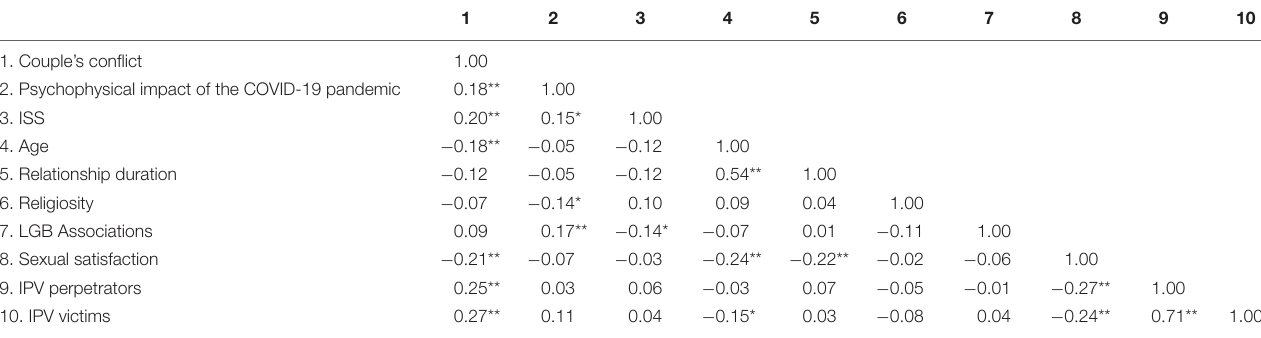
TABLE 2 | Correlations between couples’ conflict, the psychophysical impact of the COVID-19 pandemic, ISS, and other variables included in the study. 1 2